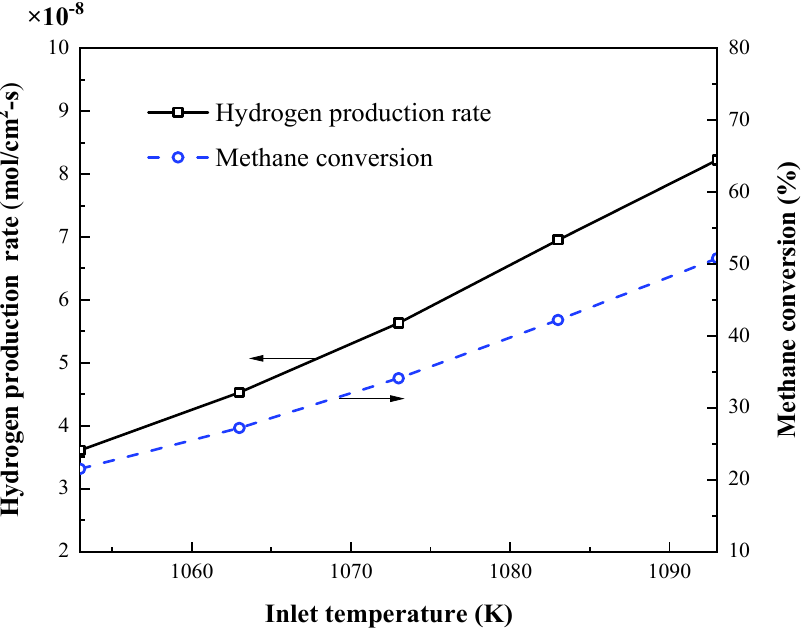
Figure 14. Effect of inlet temperature on oxygen permeation rate.